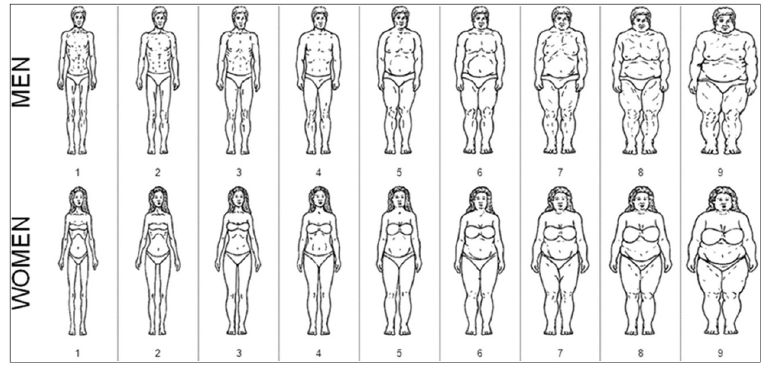
Fig 1. Pulvers’ silhouettes designed for populations of African-origin. Source: Pulvers 2004, Obesity Res.